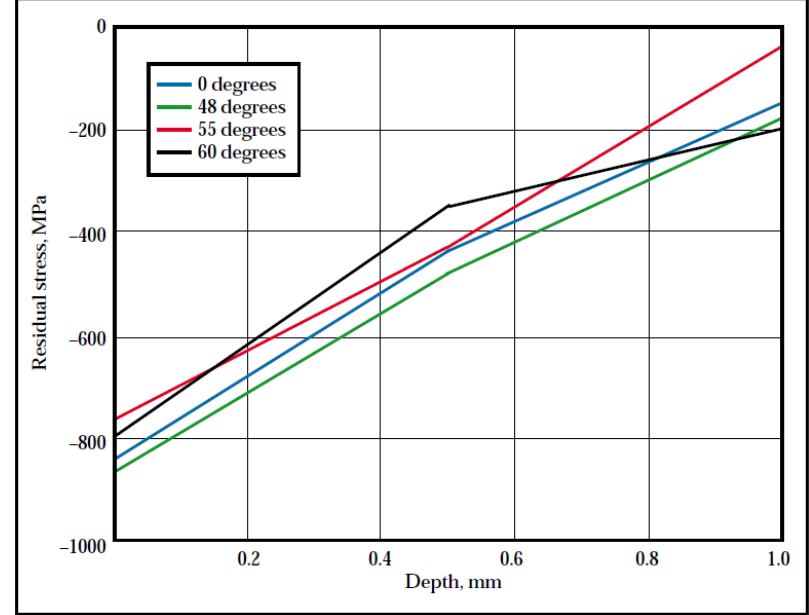
Figure 12. Residual stress profiles in laser peened Ti-6Al-4V for various laser incidence angles